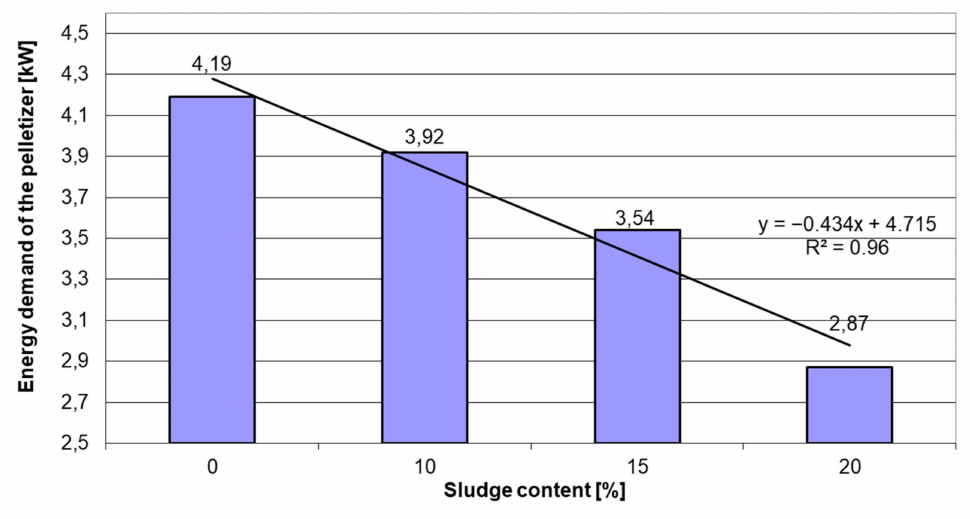
Figure 5. The dependence of the energy demand of the pelletizer on the content of post-flotation dairy sewage sludge in the mixture with sawdust.